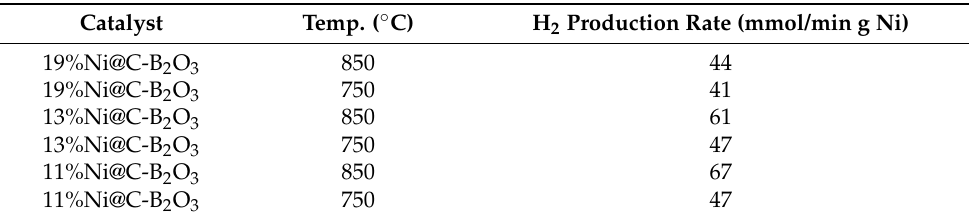
Table 7. The catalytic performance of Ni catalysts prepared using the core-shell method with different Ni loadings